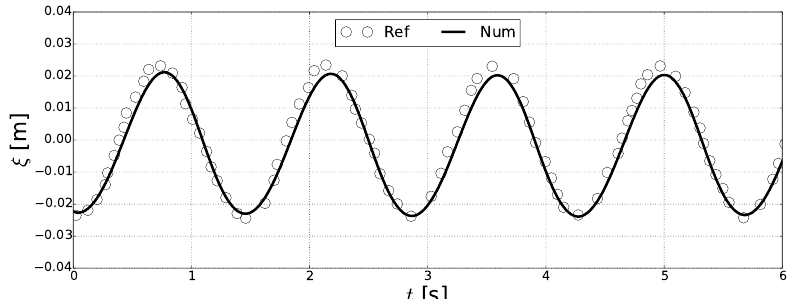
Figure 19. Numerical solution for the surge motion over time with regular waves. The numerical reference solution was taken from [54].